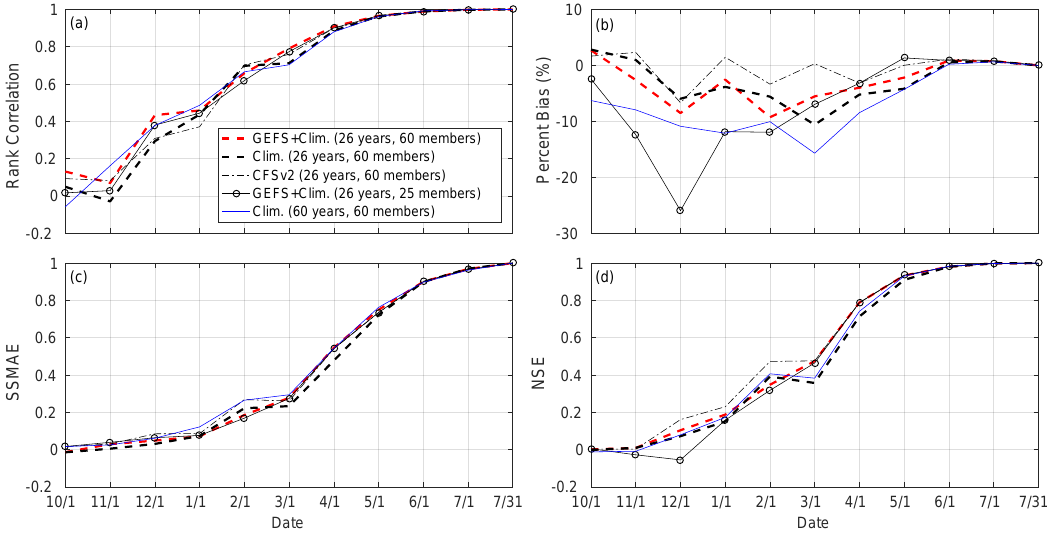
Figure 11. Statistical metrics at the monthly scale: ( a ) rank correlation; ( b ) percent bias (%); ( c ) mean absolute error skill score and ( d ) Nash–Sutcliffe efficiency of median forecasts generated from five different scenarios for Folsom Lake drainage area (FOLC1).